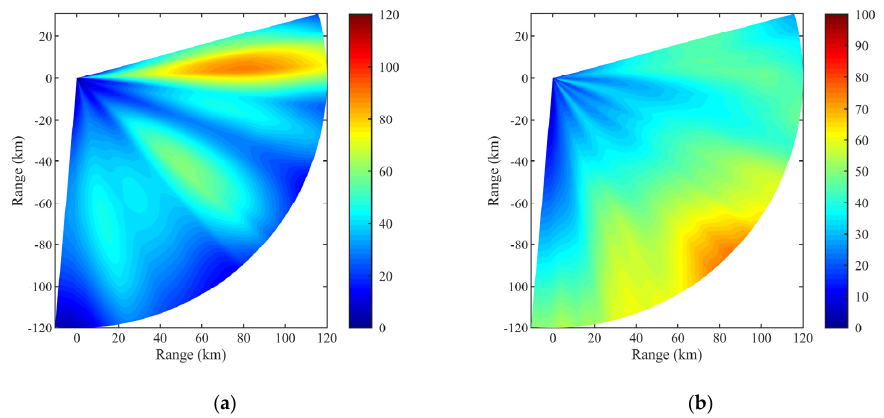
Figure 13. Regional distributions of the duct parameters estimated by the refractivity from clutter (RFC) method: ( a ) duct height (m); and ( b ) duct strength (M-units). (RFC) method: ( a ) duct height (m); and ( b ) duct strength